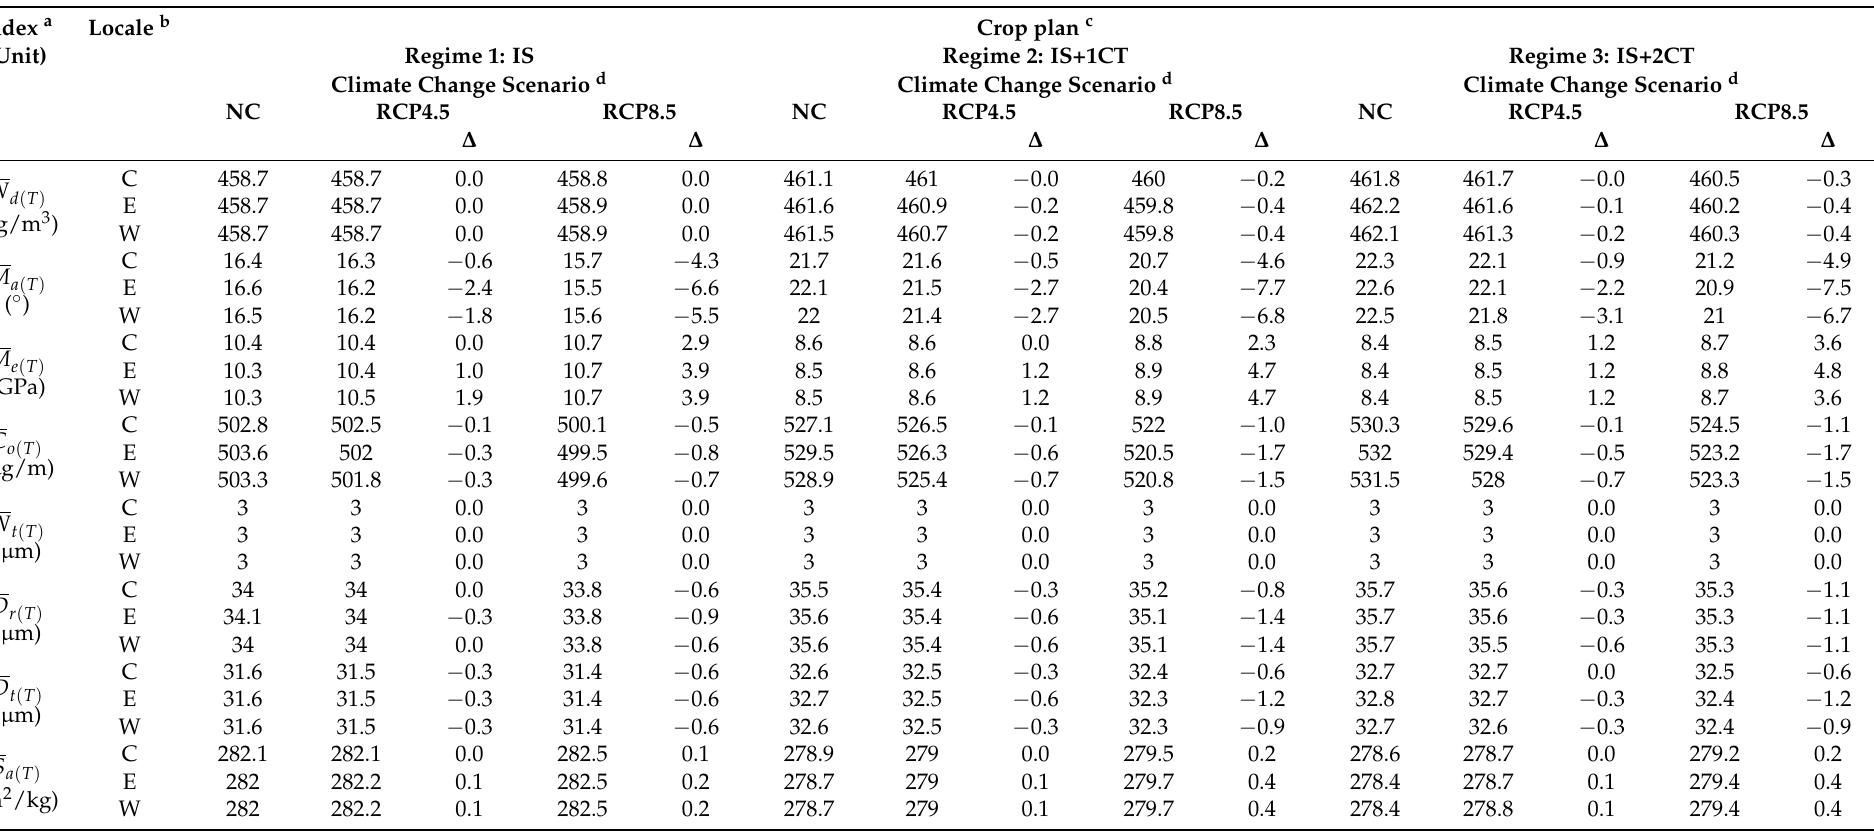
Table 3. c Crop plan specifics provided in Table 2. d Climate change scenario specifics provided in Table